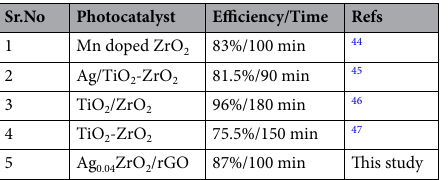
Table 2. A general comparison of the ZrO 2 based photocatalyst for the degradation of MO from literature with the present